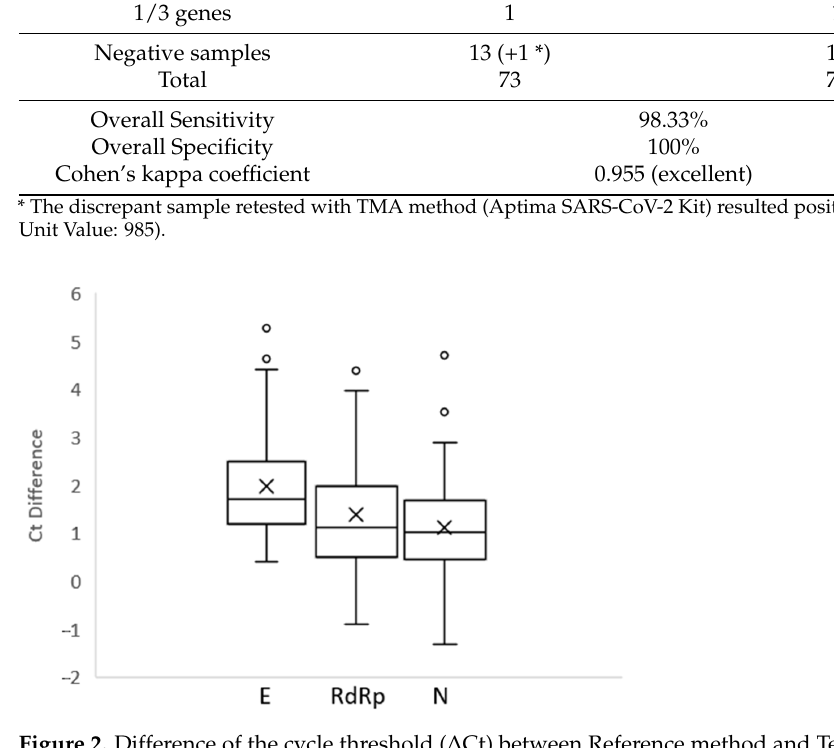
Figure 2. Difference of the cycle threshold ( Δ Ct) between Reference method and Testing method.